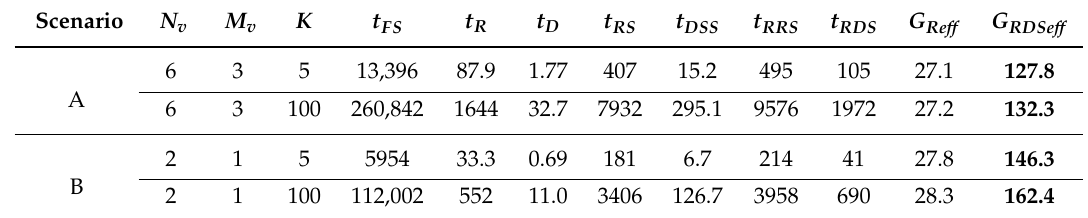
Table 2. The cumulated times of MOR, diagonalization and solution of the systems of equations (in seconds) along with MOR and diagonalization gains for two tuning scenarios, q = 10, p 0 = 10, M = 8, M 0 = 4, and for varying numbers of tuning parameters N v , modified subdomains M v and iterations K .